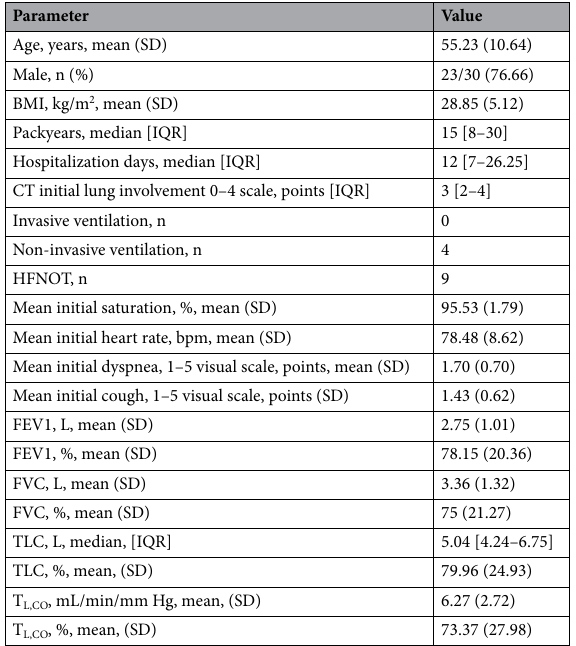
Table 1. Characteristics of study participants. BMI body mass index, CT computed tomography, FEV1 forced expiratory volume in 1 s, FVC forced vital capacity, HFNOT high flow nasal oxygen cannula, TLC total lung capacity, T L,CO transfer factor of the lung for carbon monoxide.